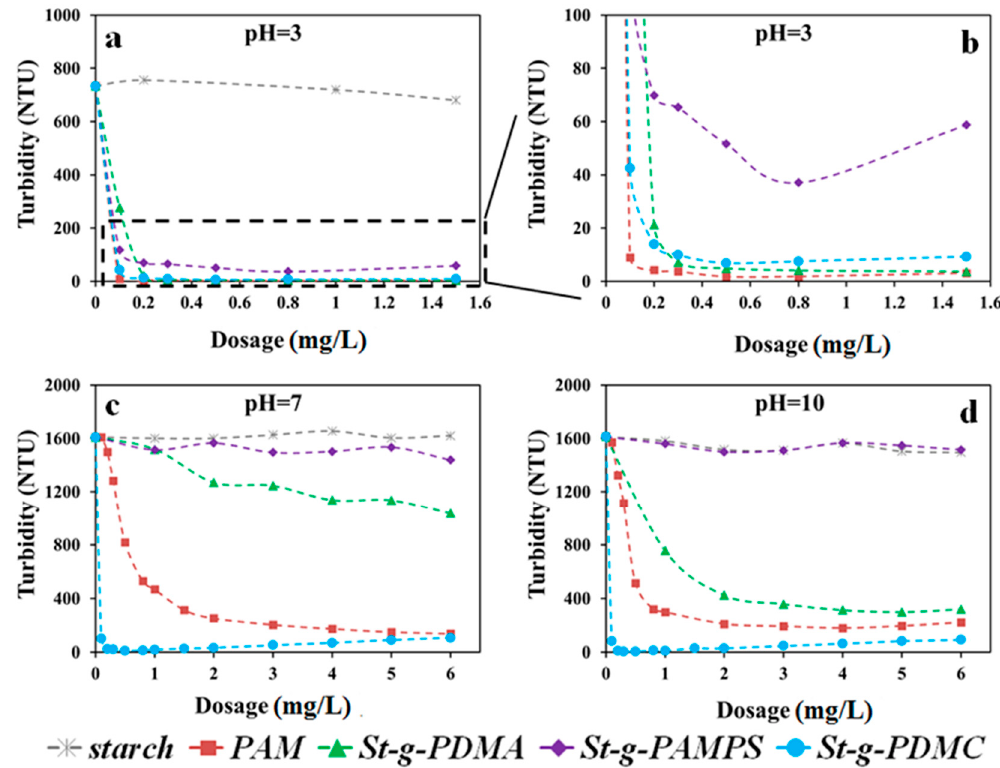
Figure 7. Turbidity versus dosage for the investigated polymer flocculants in Calcined kaolin suspensions under pH 3.0 ( a , b ), 7.0 ( c ) and 10.0 ( d ). Figure 7b is the enlargement of a section in the Figure 7a.